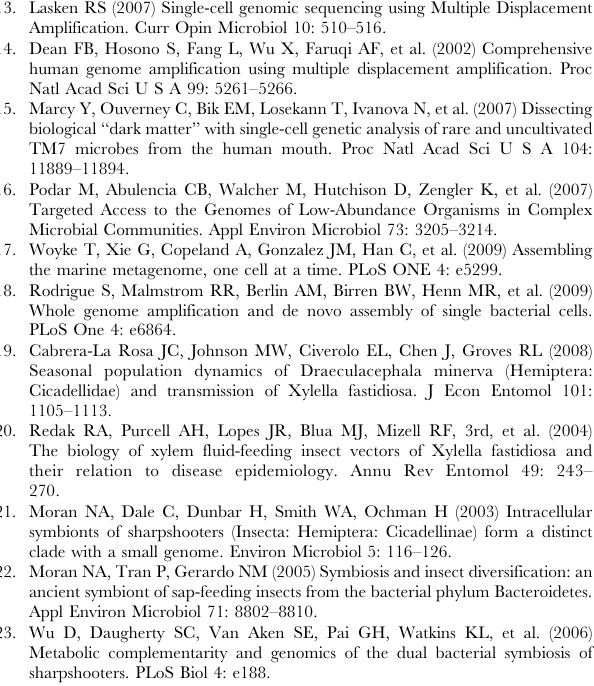
Figure S1 Digital PCR on Sulcia single cell genomes. (A) Single Sulcia DMIN cells 1–4 were isolated using micromanipulation to determine the genome copy numbers using digital PCR. Cells were viewed with a LD A-Plan 20 6 objective, Optovar 2.5 6 , DICT TL Phase 3. (B) Images of microfluidic digital PCR chips results. Approximately 5% of original sheared single cell material was loaded into the microfluidic chip for amplification. This led us to count 180 genome copies for cell 1 (both loci), 140 (locus A) respectively 240 (locus B) genome copies for cell 2, 740 (locus A) respectively 880 (locus B) genome copies for cell 3, and 480 genome copies for cell 4 (both loci). Figure S2 GC content of sequence reads. Reads were binned as based on blastx and phylogenetic assignments using lowest common ancestor algorithms in MEGAN. Approximately 35% of the reads were assigned to Proteobacteria while , 43% could not be assigned due to the lack of BLASTX ‘hits’ in NCBI. Many of the proteobacteria-related reads could be identified as Delftia acidovorans with 97–100% nucleotide-level identity to the published D. acidovorans SPH-1 genome. The read bin without assignment may largely contain reads from the host insect, which has not been sequenced. Approximately 11% of the reads were assigned to the phylum of Bacteroidetes, representative of the Sulcia genome reads. The remaining 11% of the reads were either assigned to Eukarya ( , 3%), other bacterial phyla ( , 1%) or to other tree nodes higher than phylum level ( , 7%). Figure S3 Circular view of the Candidatus Sulcia muellerii DMIN genome. Circles correspond to following features, starting with outermost circle: (1) genes on forward strand (color by COG categories), (2) genes on reverse strand (color by COG categories), (3) RNA genes (tRNAs green, sRNAs red, other RNAs black), (4) GC content and (5) GC skew.